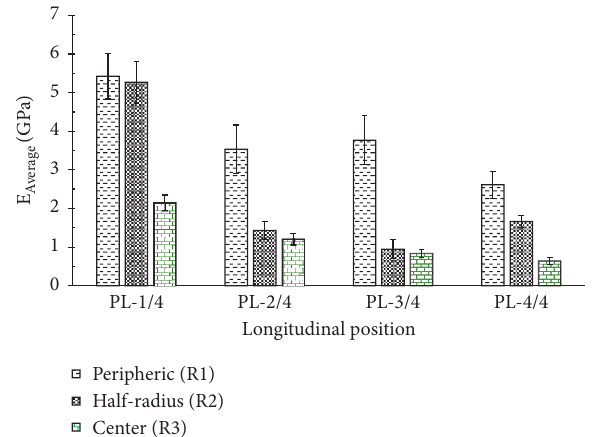
Figure 10: Distribution of Young’s modulus in the tensile test of the RVP matrix along the